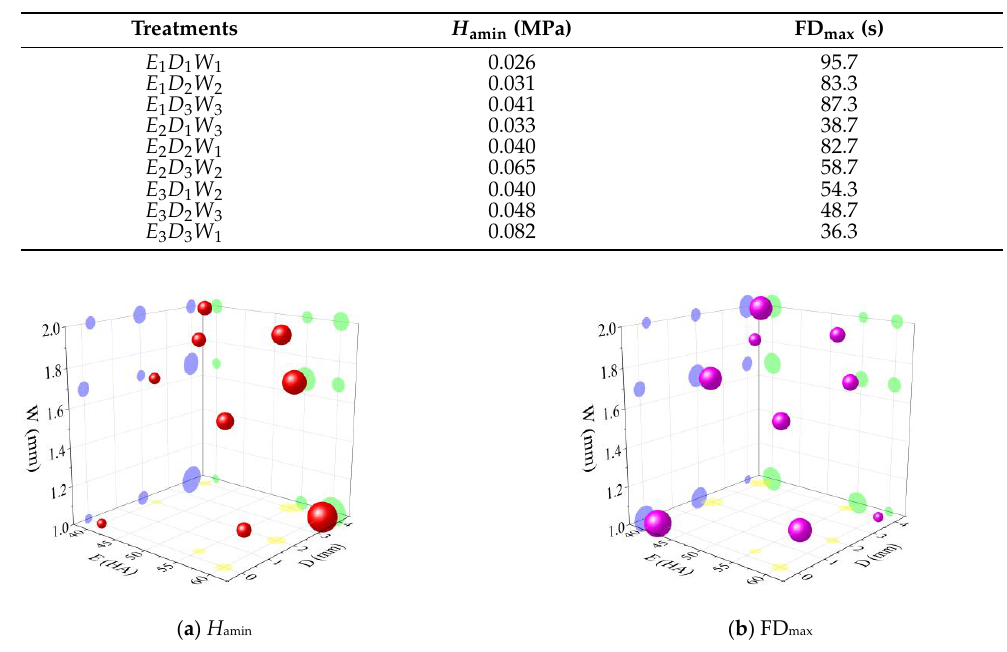
Figure 4. Automatic flushing valve minimum closing pressure ( H amin ) ( a ) and maximum flushing duration (FD max ) ( b ), three-dimensional distribution of experimental results. Note: The diameter of the sphere or circle is proportional to the value of H amin ( a ) or FD max ( b ); the red sphere represents H amin ; the magenta sphere represents FD max ; the blue, yellow and green circles represent the projections of H amin ( a ) or FD max ( b ) on the three faces of D - W , E - D and E - W , respectively.